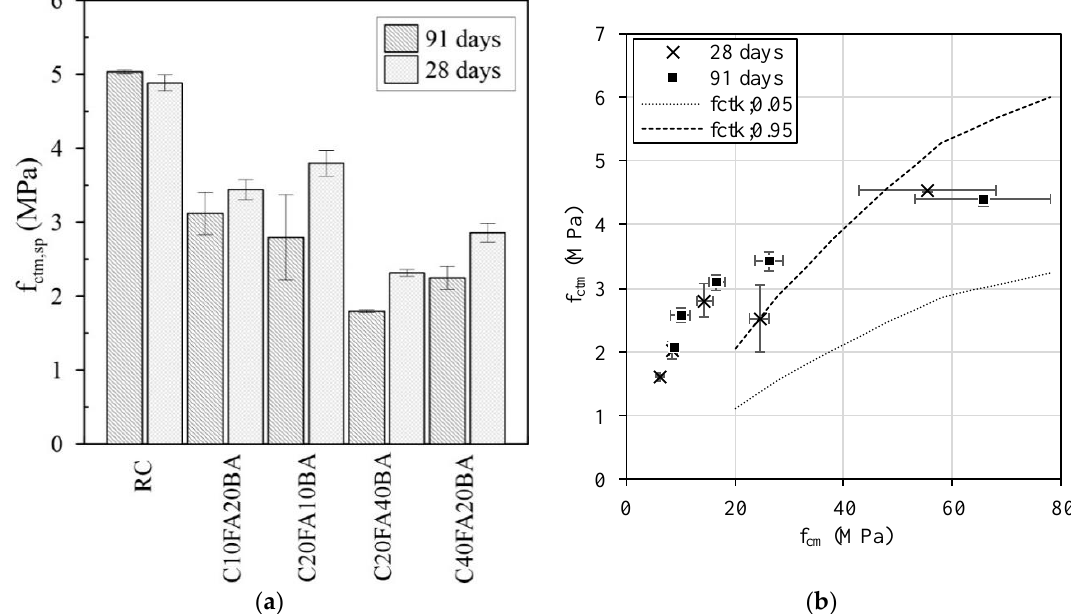
Figure 6. Tensile strength (f ctm,sp ) versus substitution rate ( a ); relationship between tensile strength (f ctm ) and compressive strength in cylindrical specimens (f cm ) at 28 and 91 days ( b ).